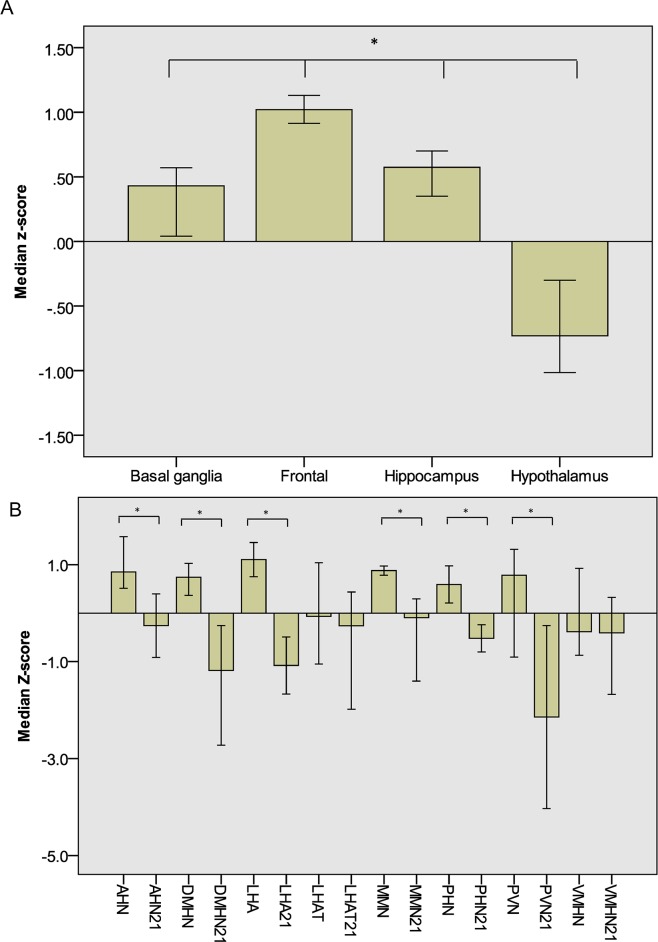
MYT1L expression in human brain.(A) MYT1L expression levels are significantly higher in the frontal cortex than hippocampus, basal ganglia or hypothalamus in adult brain (p<0.001). Data presented as median z-score +/- 95% confidence interval. (B) MYT1L expression levels in the developing hypothalamus are significantly higher at 15–16 post conception weeks than 21 post conception weeks (p<0.001). The labels on the x-axis with 21 indicate expression at 21 post conception weeks, the x-axis labels without 21 indicate expression at 15–16 weeks. Data presented as median z-score +/- 95% confidence interval AHN = anterior hypothalamic nucleus. DMHN = dorsomedial hypothalamic nucleus. LHA = lateral hypothalamic area. MMN = medial mammillary nucleus. PHN = posterior hypothalamic nucleus. PVN = paraventricular nucleus. VMHN = venteromedial hypothalamic nucleus.